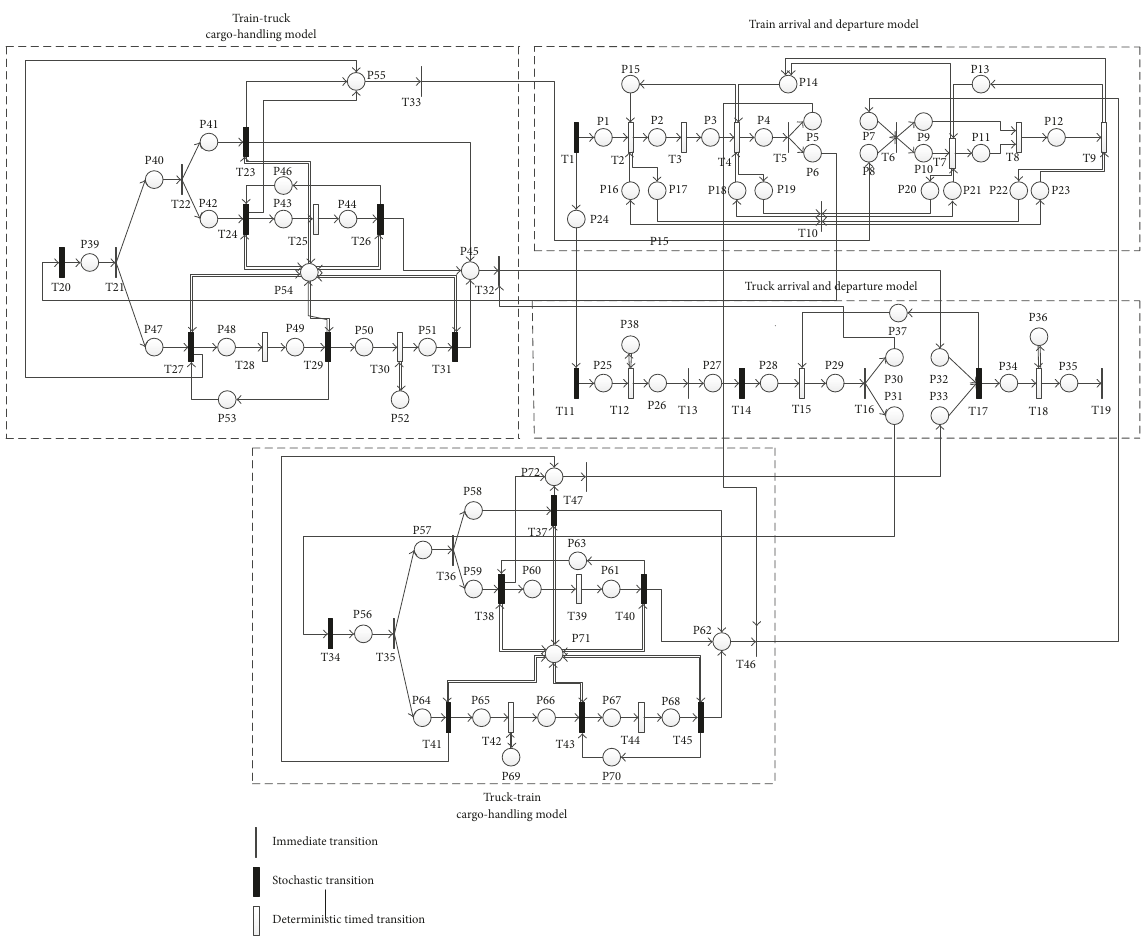
Figure 7: TPN model of multiyards railway intermodal